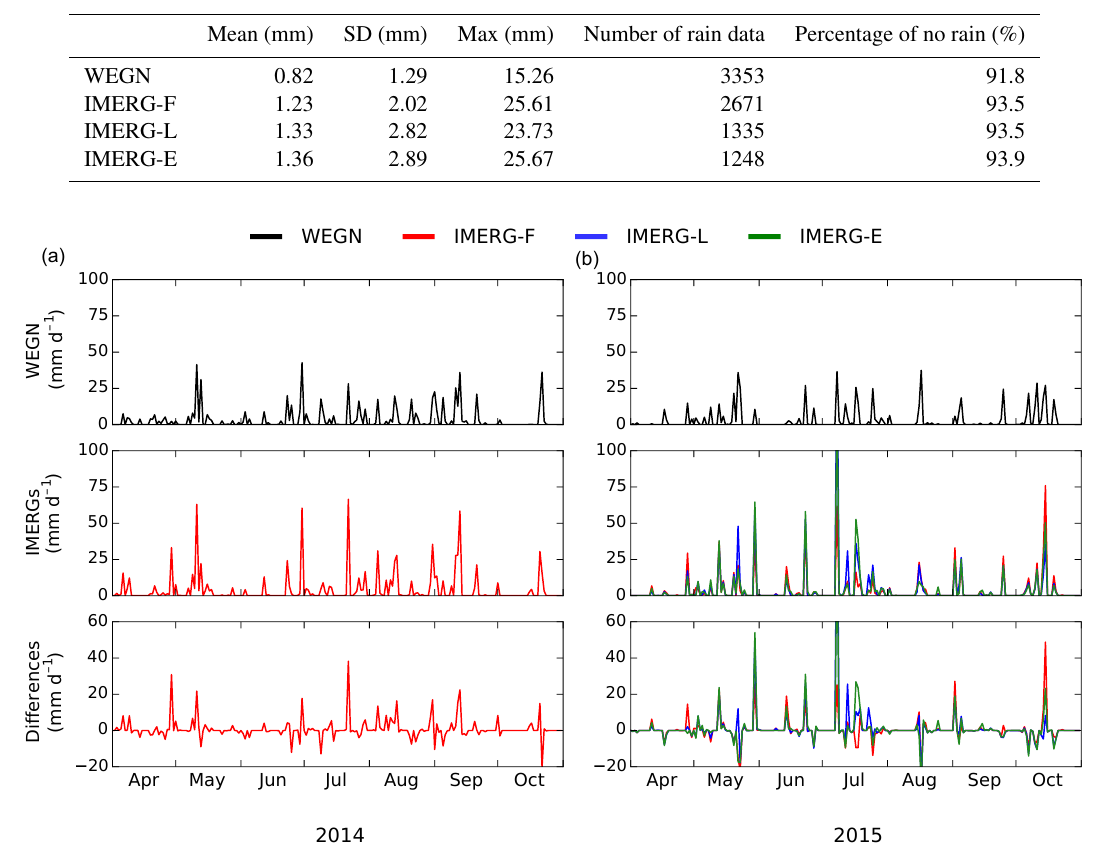
Figure 3. Accumulated 24h rainfall (mmday − 1 ) over the study periods in 2014 (a) and 2015 (b) , obtained from WEGN (top) and IMERG runs (middle), and differences between IMERG and WEGN (bottom). Regarding IMERG in the 2014 period, only IMERG-F data are